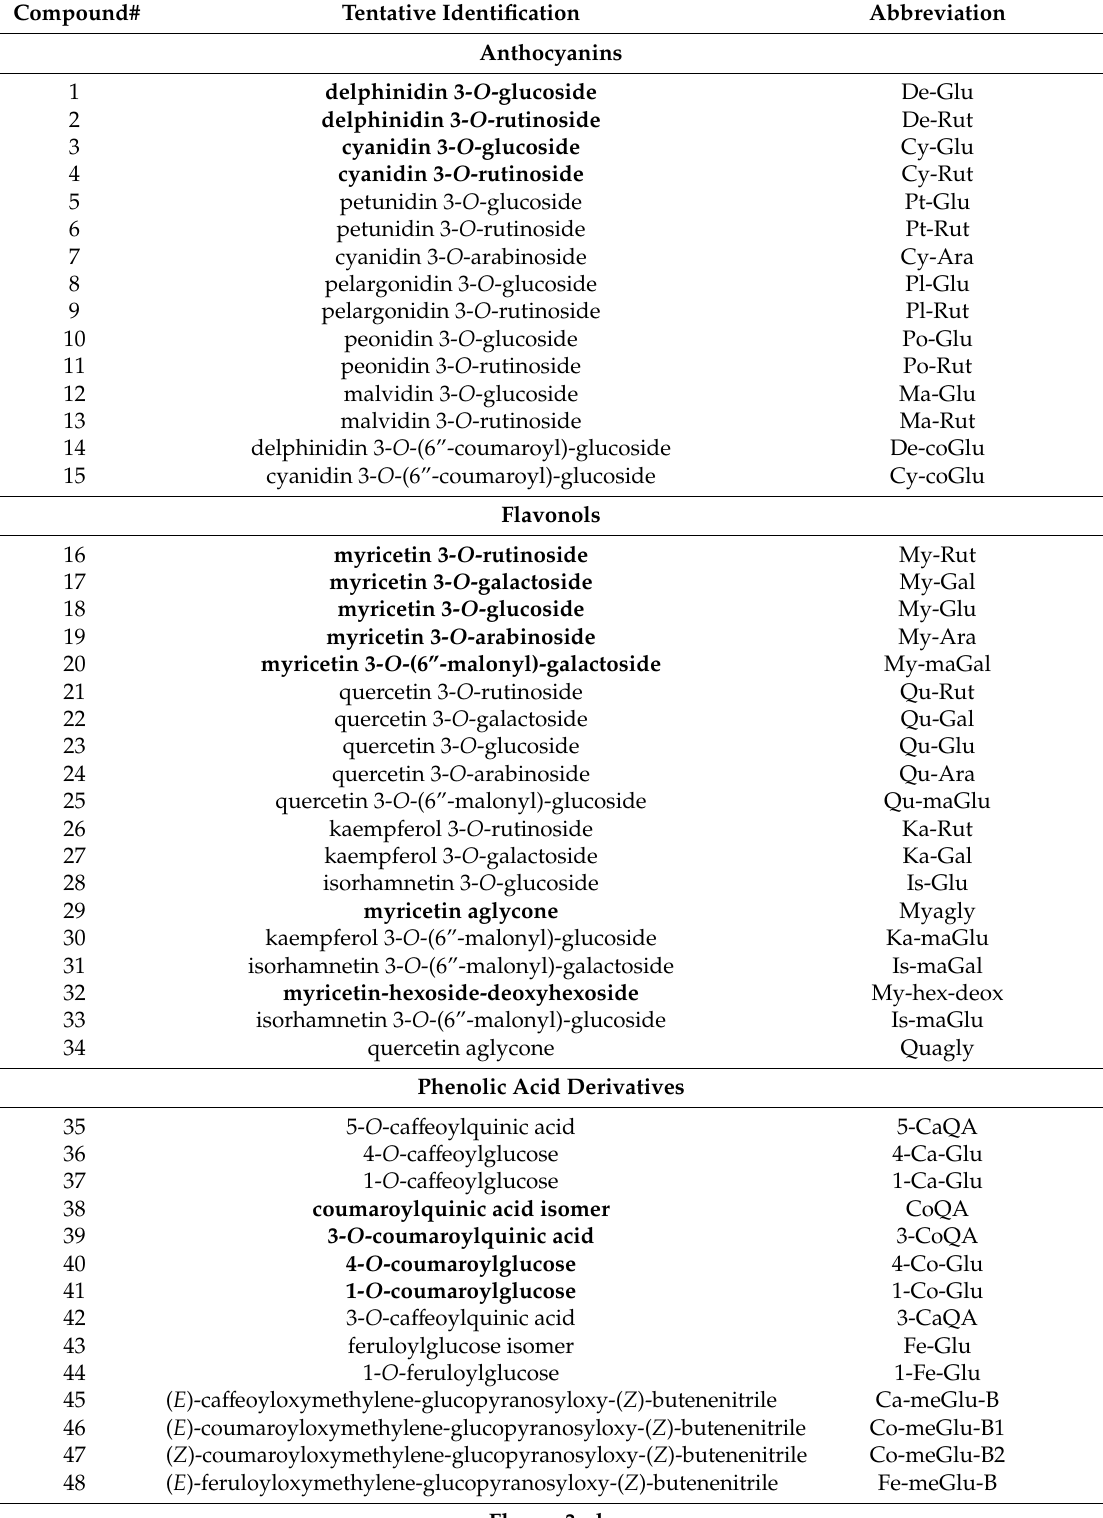
Table 1. Phenolic compounds present in 21 blackcurrant cultivars grown in five di ff erent countries in